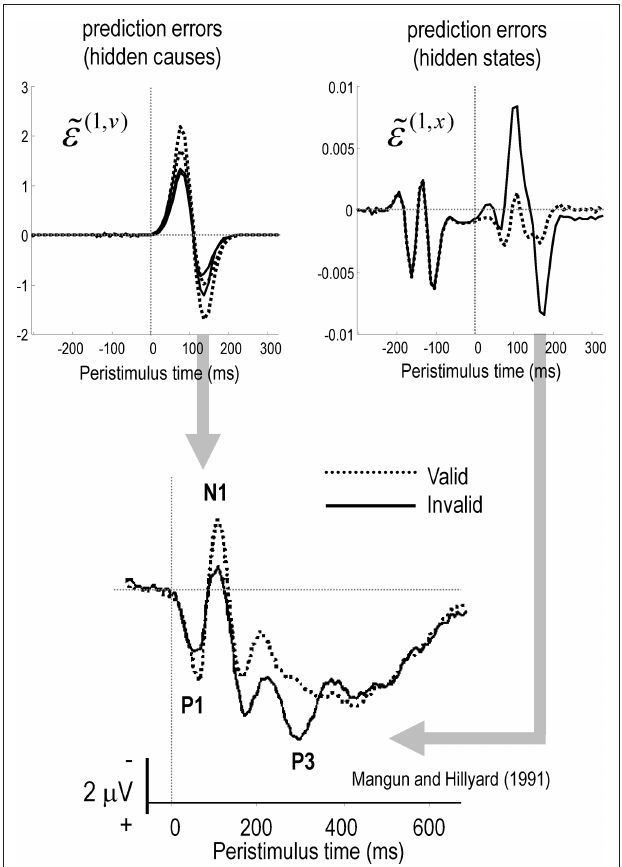
Figure 6 | Simulated eeg data from our simulations (upper panels) and empirical eeg data (lower panel) from Mangun and Hillyard (1991). The EEG traces were created from the prediction errors on the hidden causes (left) and states (right). The empirical data were recorded via EEG from the occipital cortex contralateral to the target (i.e., the cortex processing the target). The simulated data exhibits two important features of empirical studies: early in peristimulus time, stimulus-driven responses are greater for valid cues (upper left panel) relative to invalid cues. This is often attributed to a validity enhancement of early (e.g., N1) components. Conversely, later in peristimulus time, invalid responses are greater in amplitude. This can be related to novelty (and salience) responses usually associated with late waveform components (e.g., P3). In the simulations, this invalidity effect is explained simply by greater prediction errors on inferred hidden states encoding precision (upper right panel). It is these prediction errors that report a surprising or novel context, following the failure to predict invalidly cued stimuli in an optimal